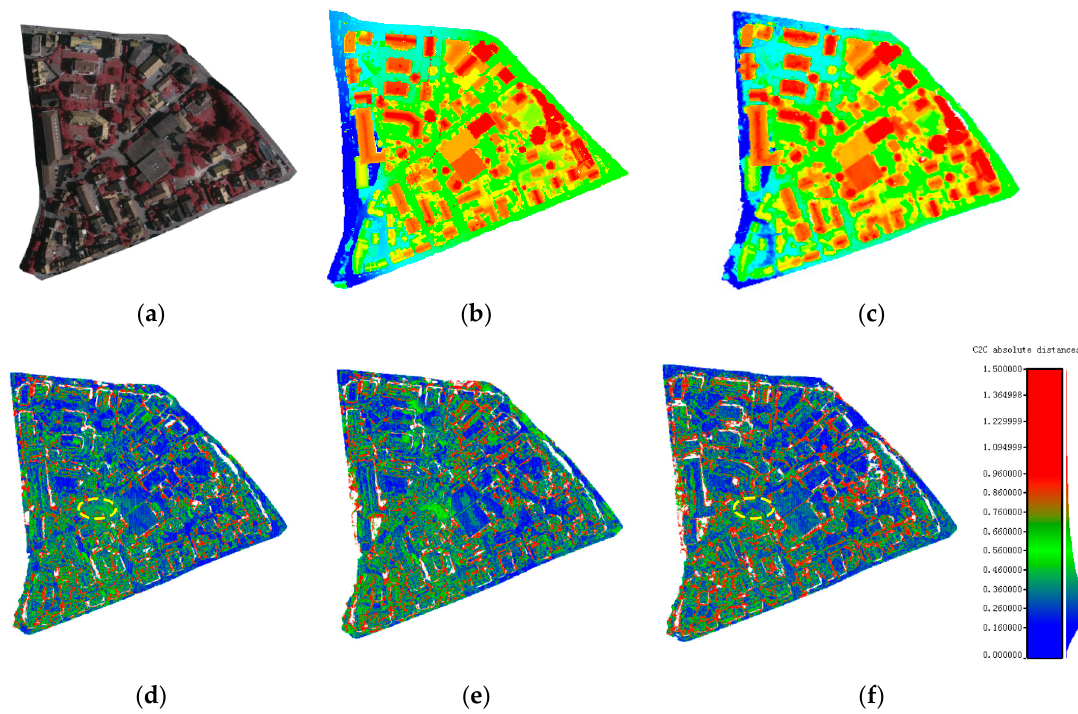
Figure 11. The dense matching results for the target area in the Vaihingen dataset: ( a ) The color image of the target area; ( b ) The height map of the reference ALS point cloud; ( c ) The height map of the DIM result from the proposed method; and ( d – f ) represent the distance deviation maps for the DIM results from the three tested configurations.